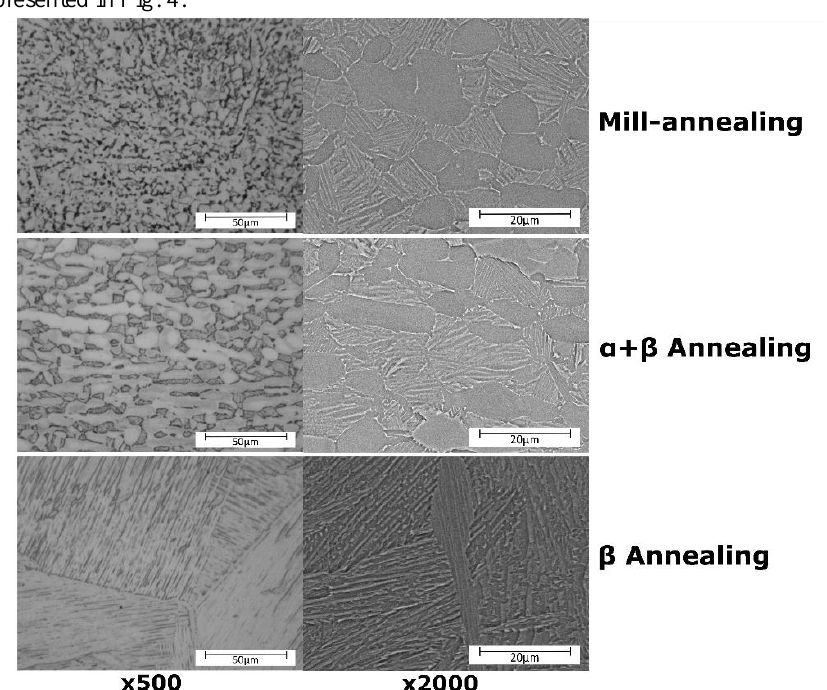
Figure 4: Optical (left) and SEM (right) Ti-6Al-4V microstructures resulting from the different HT considered in this